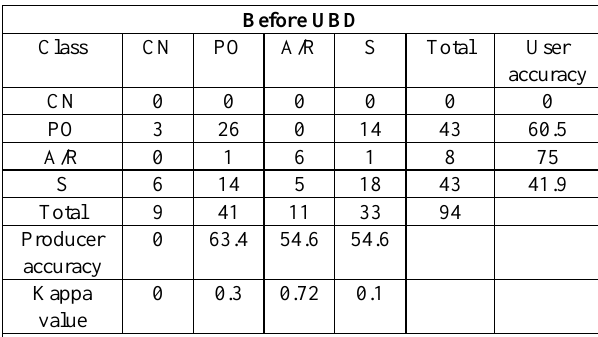
Overall accuracy: 53.2; Kappa value: Table 3. Error matrix of Fig. 2D before the application of UBD on Planet imagery. CN: Cymodocea nodosa seagrass , PO: Posidonia oceanica seagrass, A/R: Algae and Rocks, S: Sand bigger multispectral satellites like Sentinel-2 and Landsat-8. On the other hand, remote sensing of coastal ecosystems like